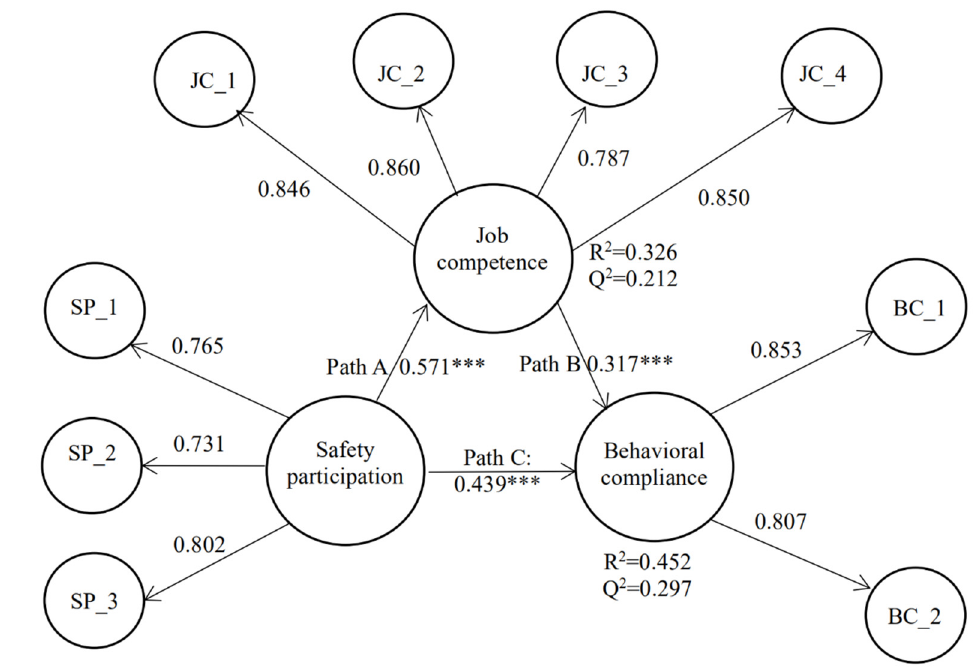
Figure 3. Model with job competence as a mediating variable.